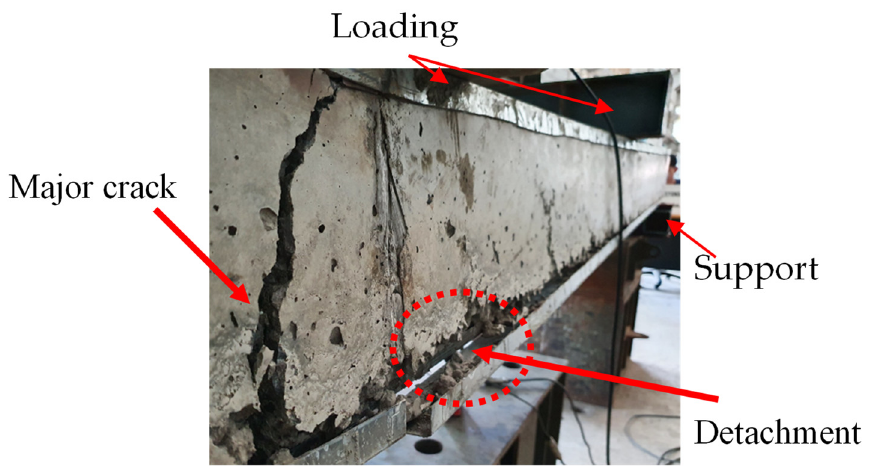
Figure 9. Failure mode of the deck (Specimen S2).